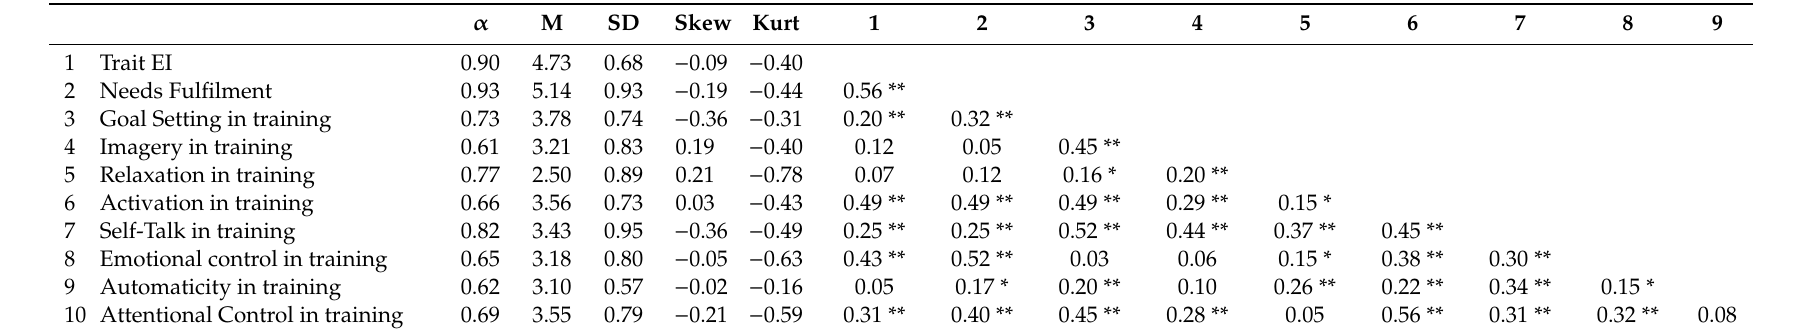
Table 1. Descriptive Analysis and Correlations in training contexts.